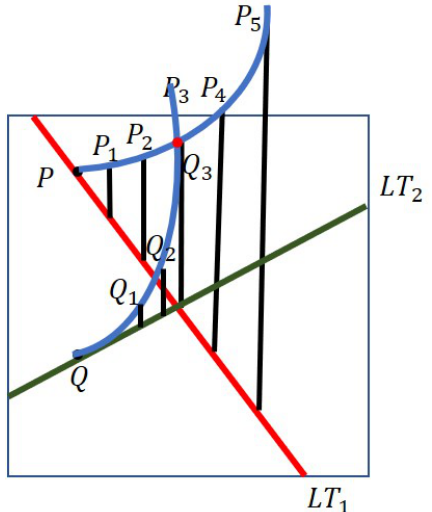
Figure 3. Inversely mapping and voting process. P is projection point. P i is target point in 3D space corresponding to different offset along iso-range line L (cid:48) . Q is another projection point which is mapped inversely along iso-range line under another aspect